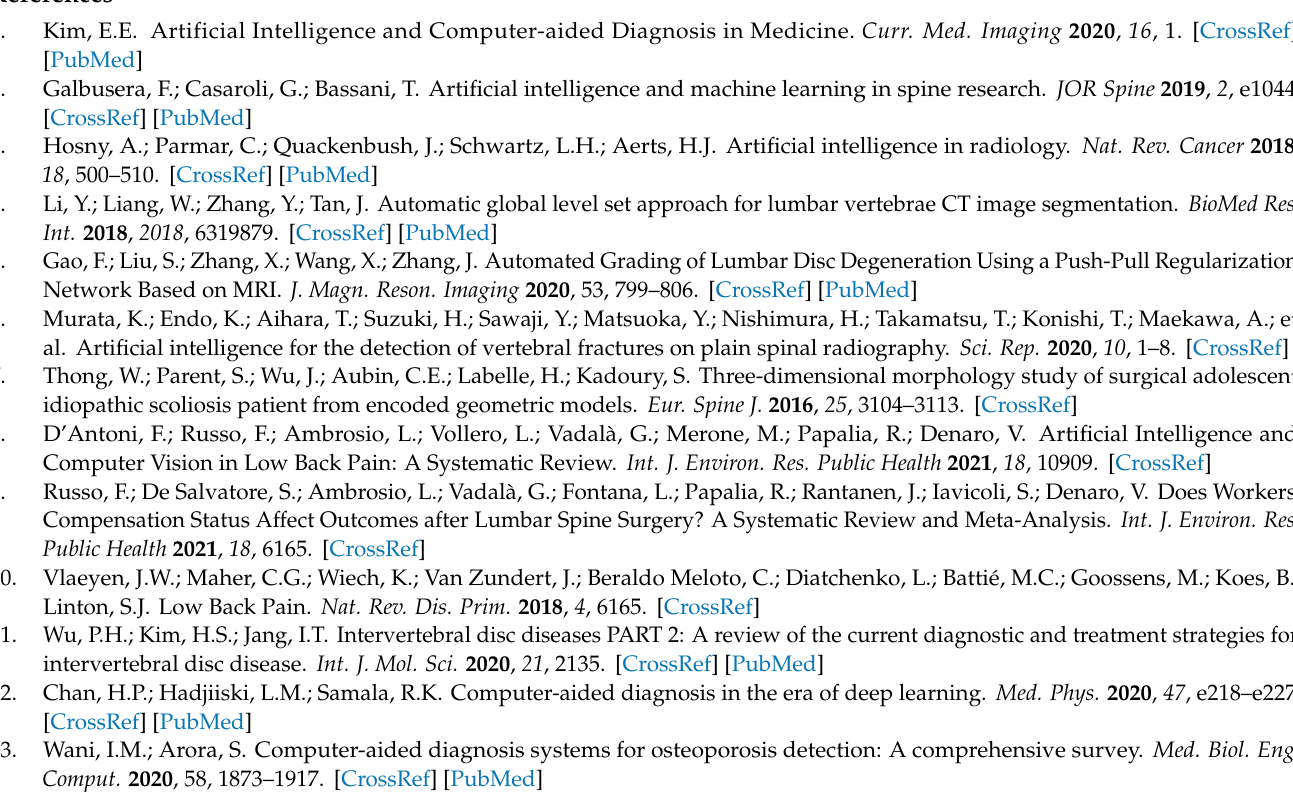
Table S2: Summary of the methodological quality of included studies regarding the three domains assessing applicability concerns of the QUADAS-2